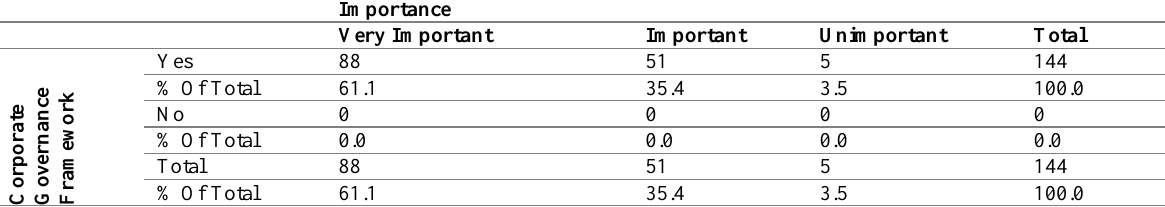
Table 2: Corporate Governance Prevalence and Importance